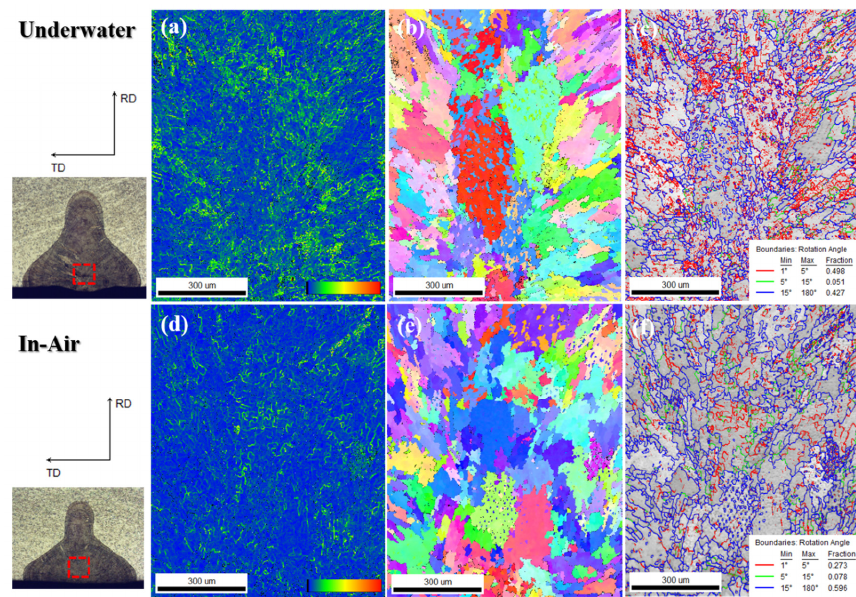
Figure 7. Electron backscatter diffraction maps of an area in the center of the weld bead (see red dashed outlines in micrographs shown left): ( a ) kernel average misorientation (KAM) map, ( b ) inverse pole figure (IPF), and ( c ) grain boundary (GB) character map for specimen prepared by underwater laser welding; and ( d ) KAM map, ( e ) IPF, and ( f ) GB character map for specimen prepared by in ‐ air laser welding.